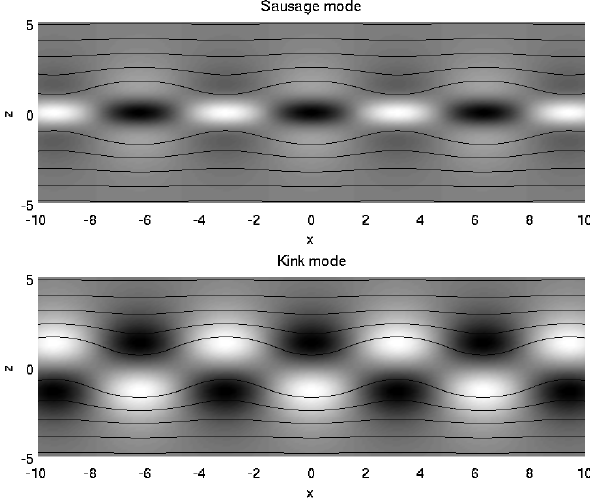
Fig. 2. Sketch of the dynamics of the plasma sheet in a sausage mode (top) and in a kink mode (bottom) configuration. Perturbed magnetic field lines are drawn together with contour plot of thermal pressure fluctuations. Black spots correspond to a higher pressure whereas white spots denotes lower thermal pressure. As the total pressure is roughly conserved, a decrease in p th is accompanied by an increase in the magnetic pressure and field lines move closer to each other, or